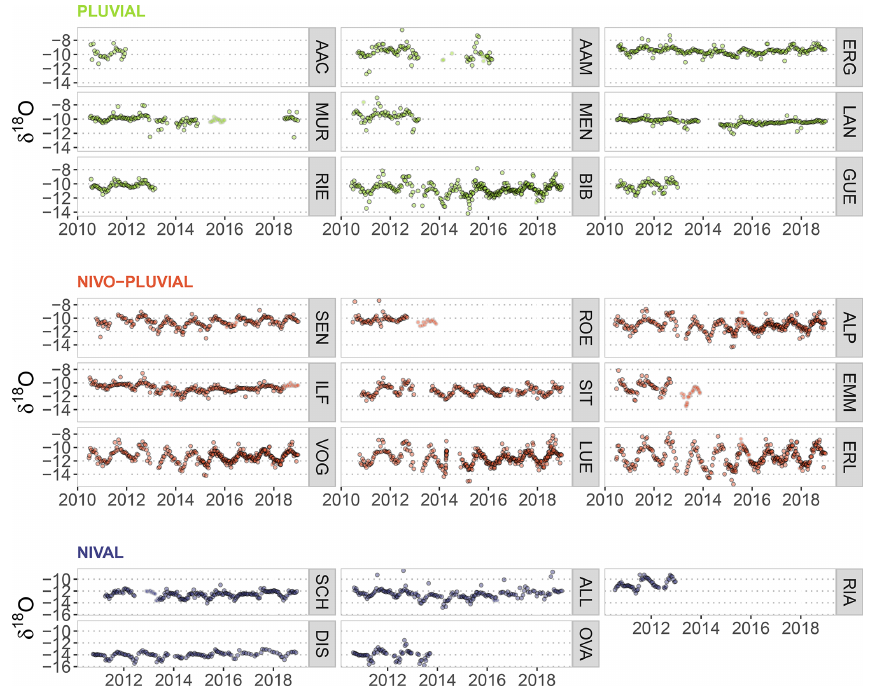
Figure 2. Fortnightly time series of δ 2 H. The colours indicate the regime type to which the catchments can be assigned. Samples that have a comment in the data are plotted as symbols without border.